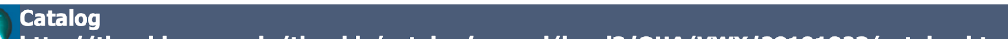
Figure 3. Nested catalogs. Only first 11 entries shown here. More entries omitted.